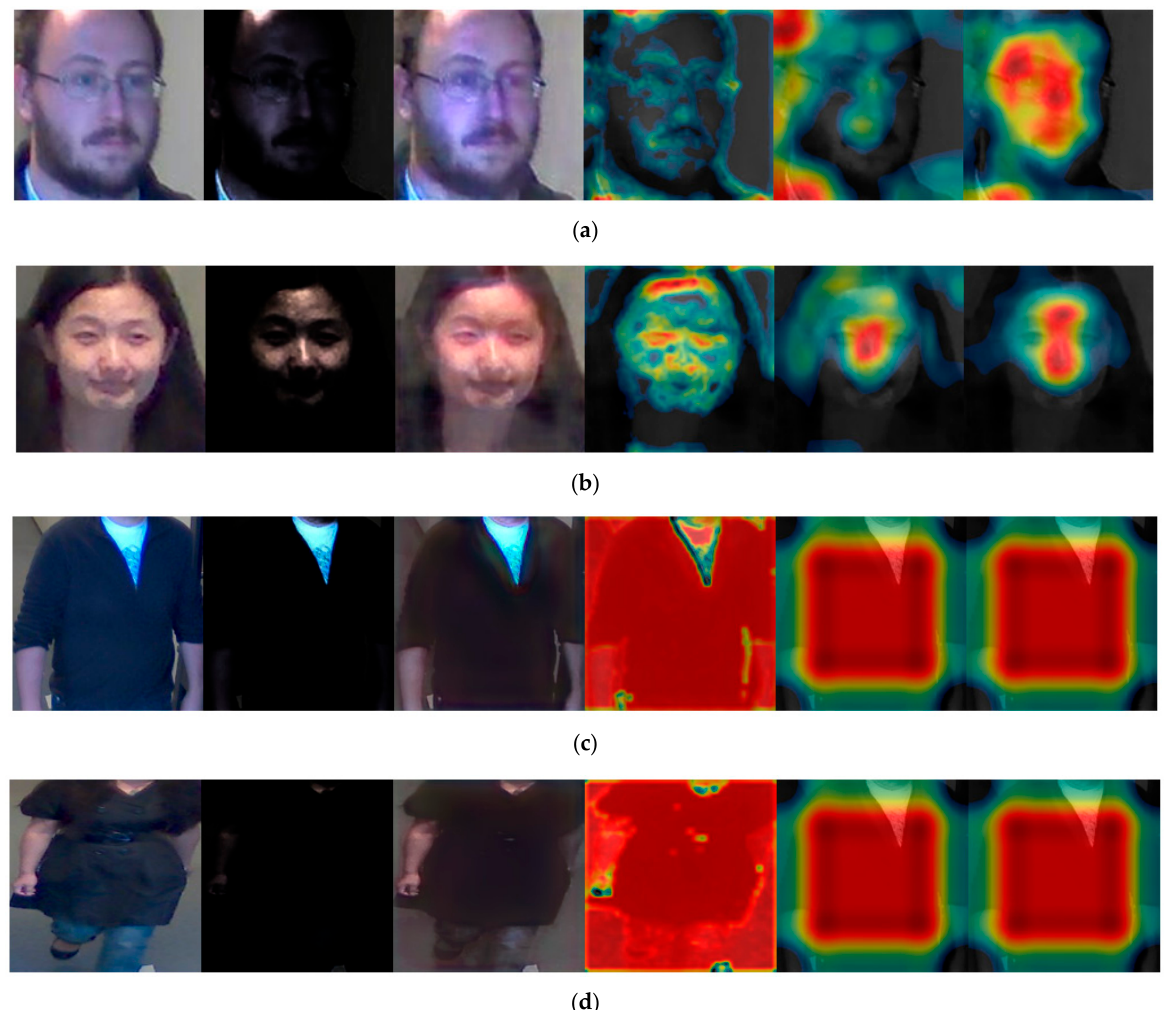
Figure 21. Results on class activation feature map on ChokePoint dataset [34]. ( a , b ) are activation map results from face images. From the left image to the right image: original image, low-illumination image, enhancement image from modified EnlightenGAN, result from 7th ReLU layer, result from 12th ReLU layer, and result from 13th ReLU layer of VGG face-net 16. ( c , d ) are activation map results from body images. From the left image to the right image: original image, low-illumination image, enhancement image from modified EnlightenGAN, result from 3rd batch-normalized layer, result from conv5 2nd block, and result from conv5 3rd block of